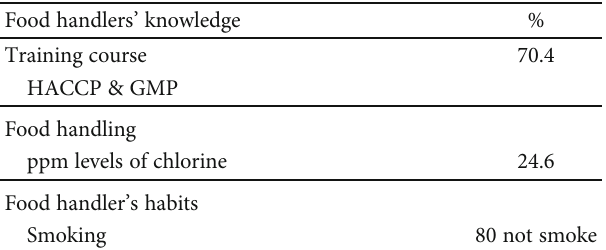
Table 2: Food handlers ’